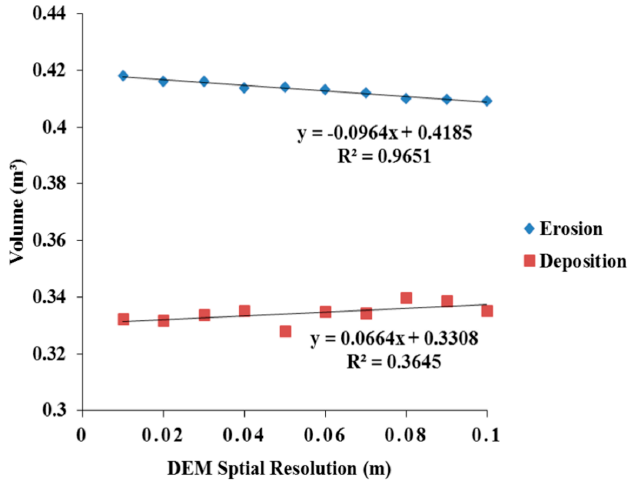
Figure 5. The impact of spatial resolutions on erosional and depositional volume estimates.